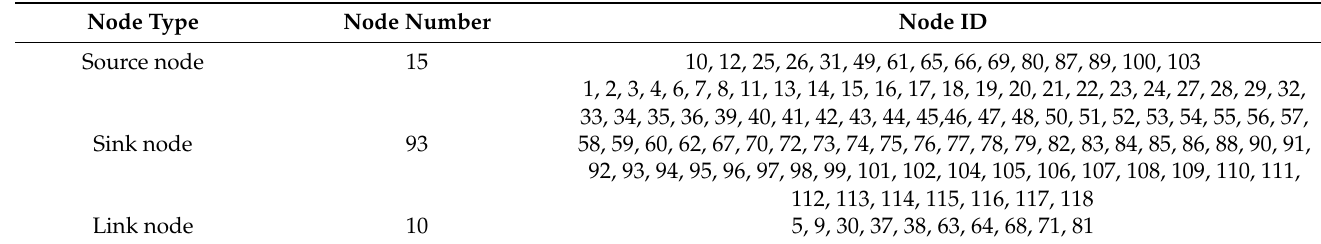
Table 2. IEEE-118 system node type.